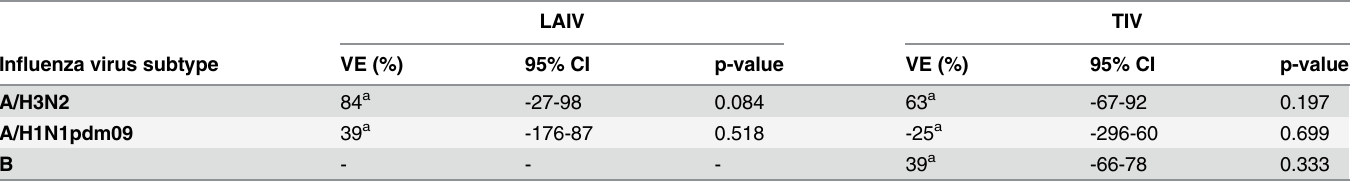
Table 6. Vaccine effectiveness of live (LAIV) and inactivated vaccines (TIV) against laboratory-confirmed influenza A(H3N2), A(H1N1)pdm09 and B; Multivariable logistic regression, Virological Surveillance, Saxony-Anhalt, Germany 2012/13, age group 2 – 17 years, (n =